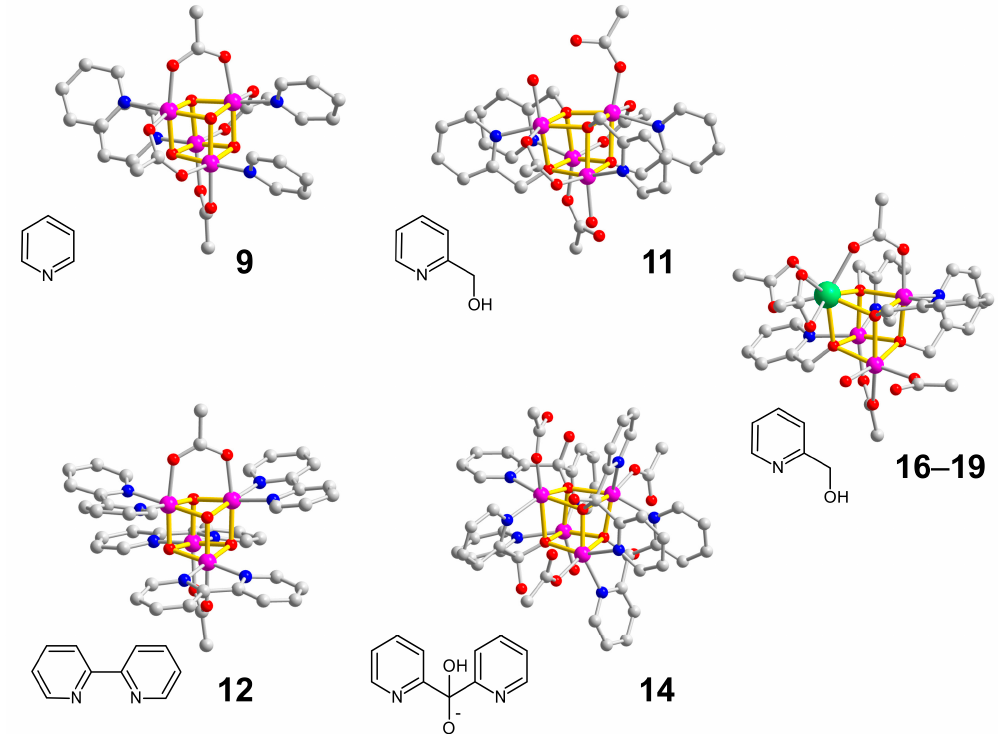
Figure 5. Structures of complexes 9 , 11 , 12 , 14 , and 16 – 19 with the schemes of respective N-donor ligands. Color scheme: Co, pink; Ln, green; O, red; N, blue; C, grey. M–O–M bonds are highlighted by yellow.